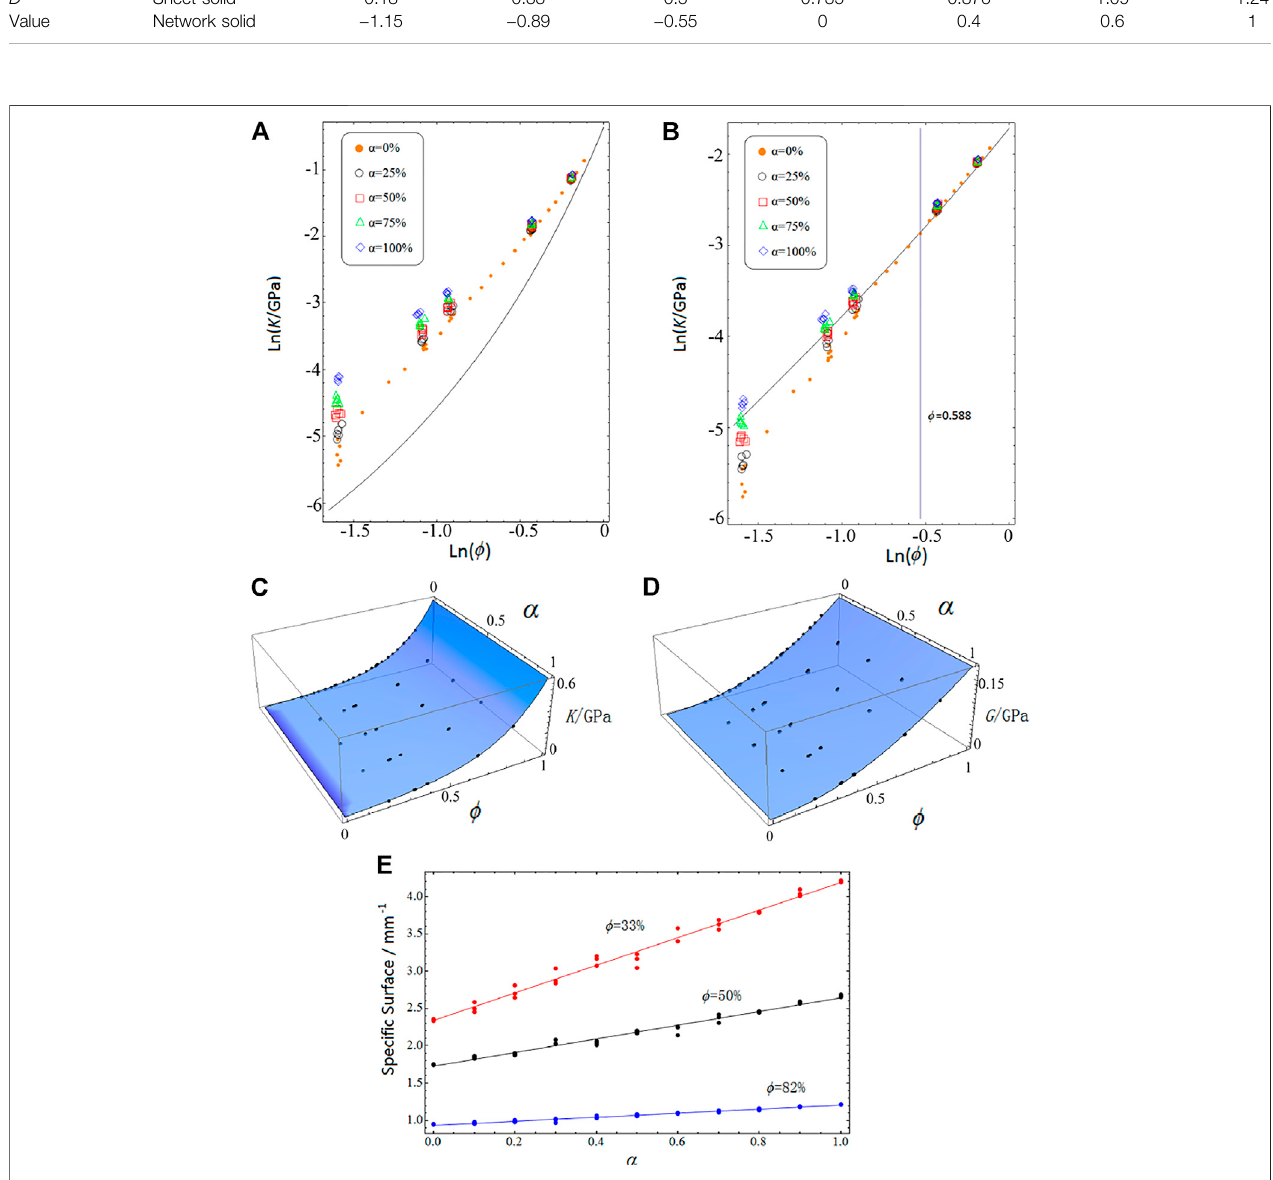
FIGURE 2 | Comparisons of the logarithm of bulk moduli (A) and shear moduli (B) versus the logarithm of SVF ( ϕ ) for TV solids and PV solids, where the points represent the results for TV solids when α = 0 (orange dots), 25% (black circles), 50% (red squares), 75% (green triangles), and 100% (blue rhombi), and the solid lines representtheresultsforPVsolids.ThebulkmoduliofTVsolidsaregreaterthanthoseofthePVsolids,buttheshearmoduliofTVsolidswithoutthesheetsolids( α =0)are lower than the PVsolids for ϕ < 0.588 but exceed the PV solid values at higher ϕ . Moreover, forlow SVF, the moduliofTV solids increase asthe sheet solid fraction ( α )increasesatagivenSVF;however,forhighSVF, α hasonlyaslighteffectonthemoduli.Thebluesurfaces (C) and (D) arethebest fi tsofbulkmodulusdataandshear modulus data for TV solids (i.e., the data represented by dots, circles, squares, triangles, and rhombi in Panel 2A,B), respectively. Five structures were constructed for each α with each ϕ . (E) The relationship between the α and speci fi c surface of TV solids for different ϕ , that is, ϕ = 33% (red), 50% (black), and 82% (blue). The speci fi c surface increases with increased α for all ϕ , but the slope of each line decreases as ϕ increases. Three structures were built for each α with each ϕ .